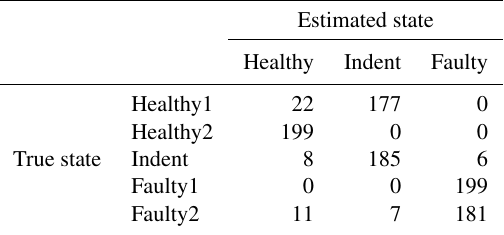
Table 4. Confusion matrix for 1500rpm MEMS data and the top four features.